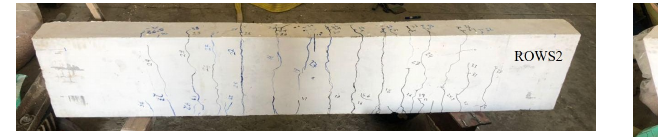
Figure 15: Bottom crack pattern of slab ROWS2.